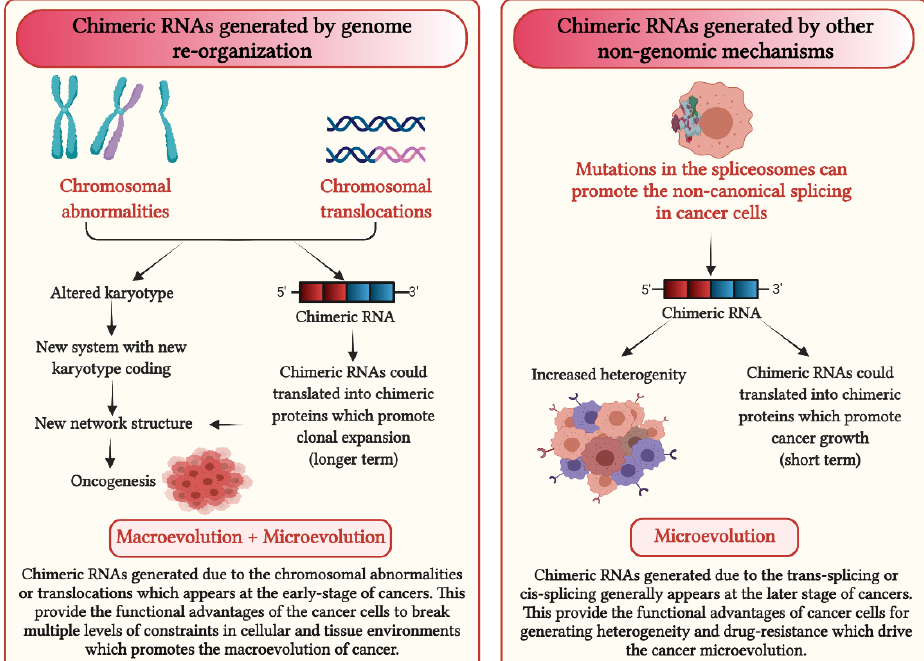
Figure 3. Impact of chimeric RNAs on cancer evolution.